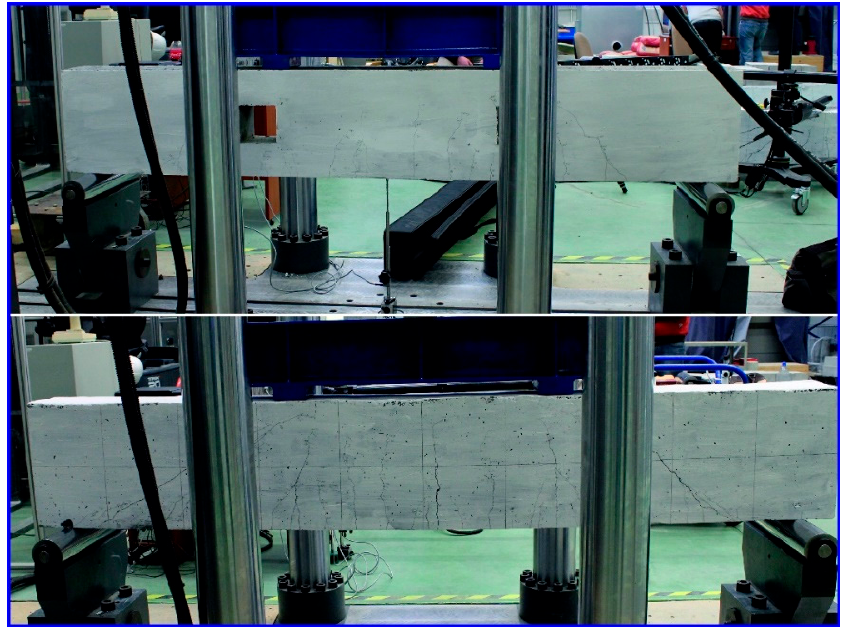
Figure 3. Test setup.